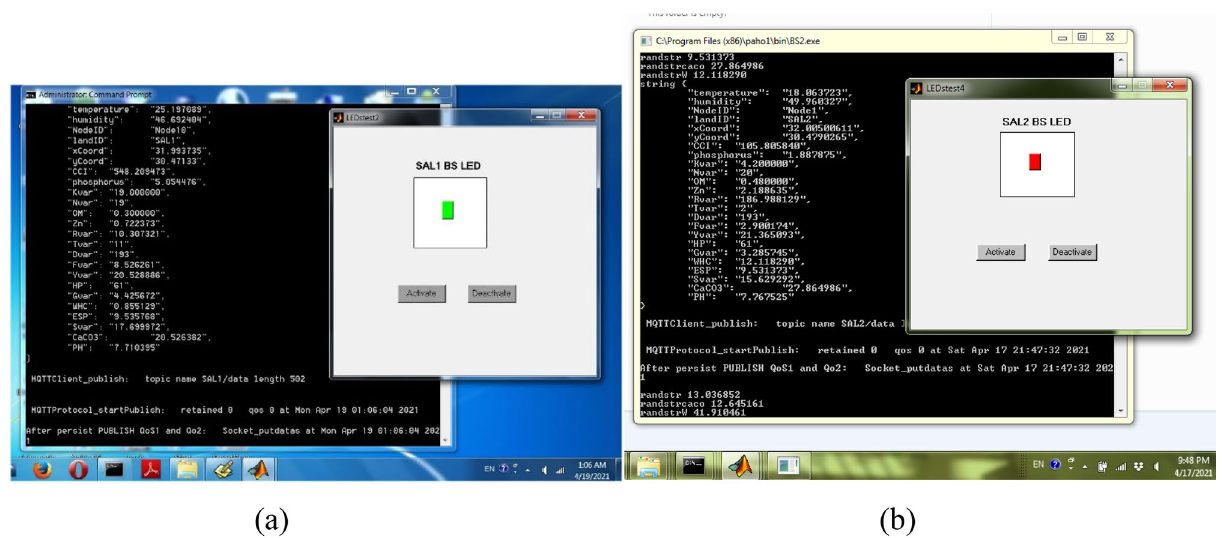
Figure 25. The action of sending commands is fired, ( a ) an Close command for Salhia land1, ( b ) an Open command for Salhia